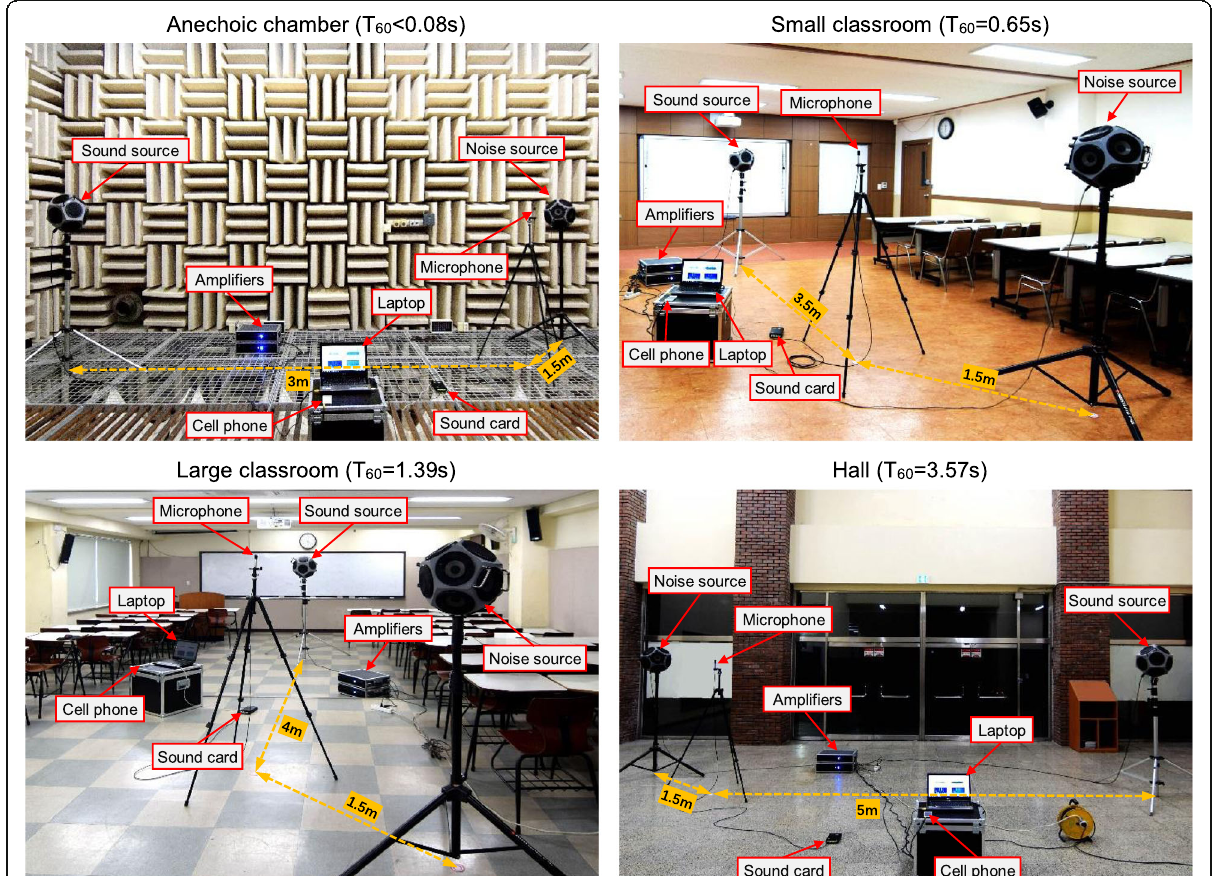
Fig. 3 Equipment layout in four different rooms. a anechoic chamber ( T 60 = 0.08s), b small classroom ( T 60 = 0.65s), c large classroom ( T 60 = 1.39s), d hall (